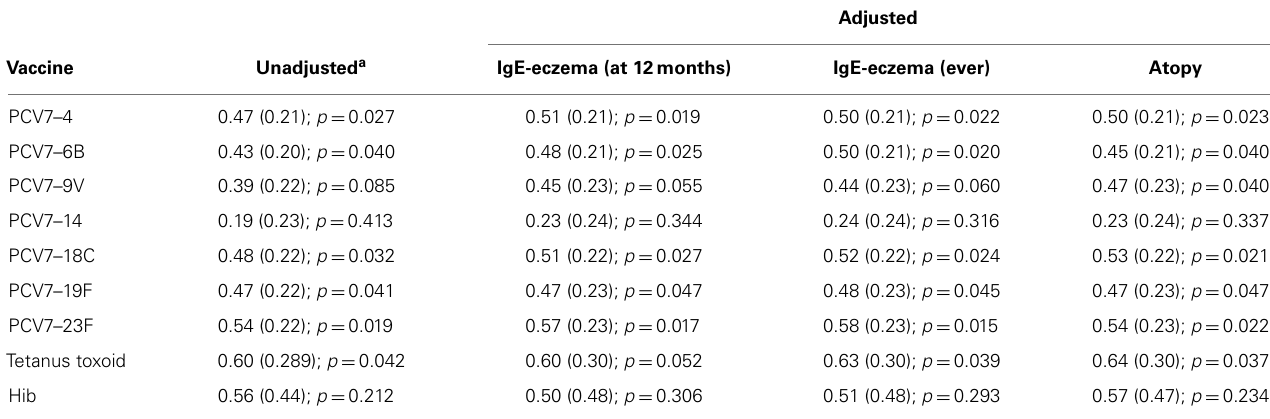
TableA1A | Summary of the vaccine-specific IgG responses following adjustment for eczema and atopy